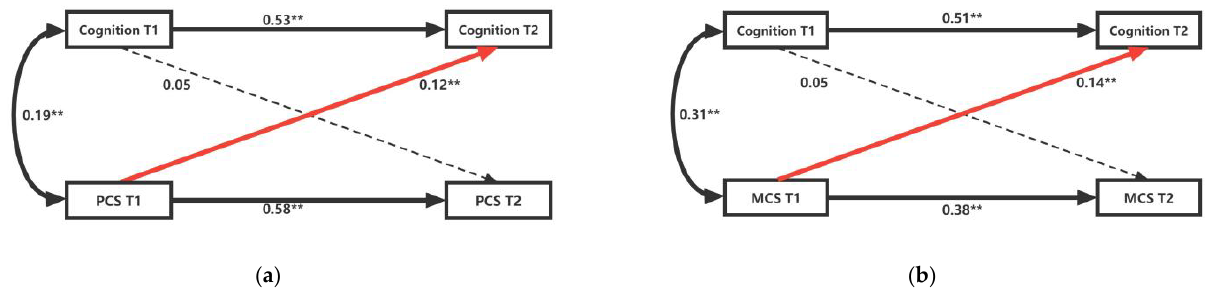
Figure 2. Cross-lag Model of Cognitive Function and HRQoL (all samples). ( a ) Model 1: the cross-lag relationship between cognitive function and PCS scores; ( b ) Model 2: the cross-lag relationship between cognitive function and MCS scores. PCS, physical component summary; MCS, mental component summary. ** denotes a statistically significant path coefficient p < 0.001.